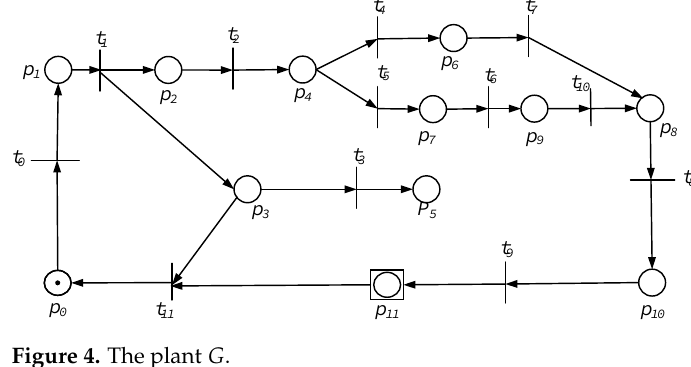
Figure 4. The plant G .